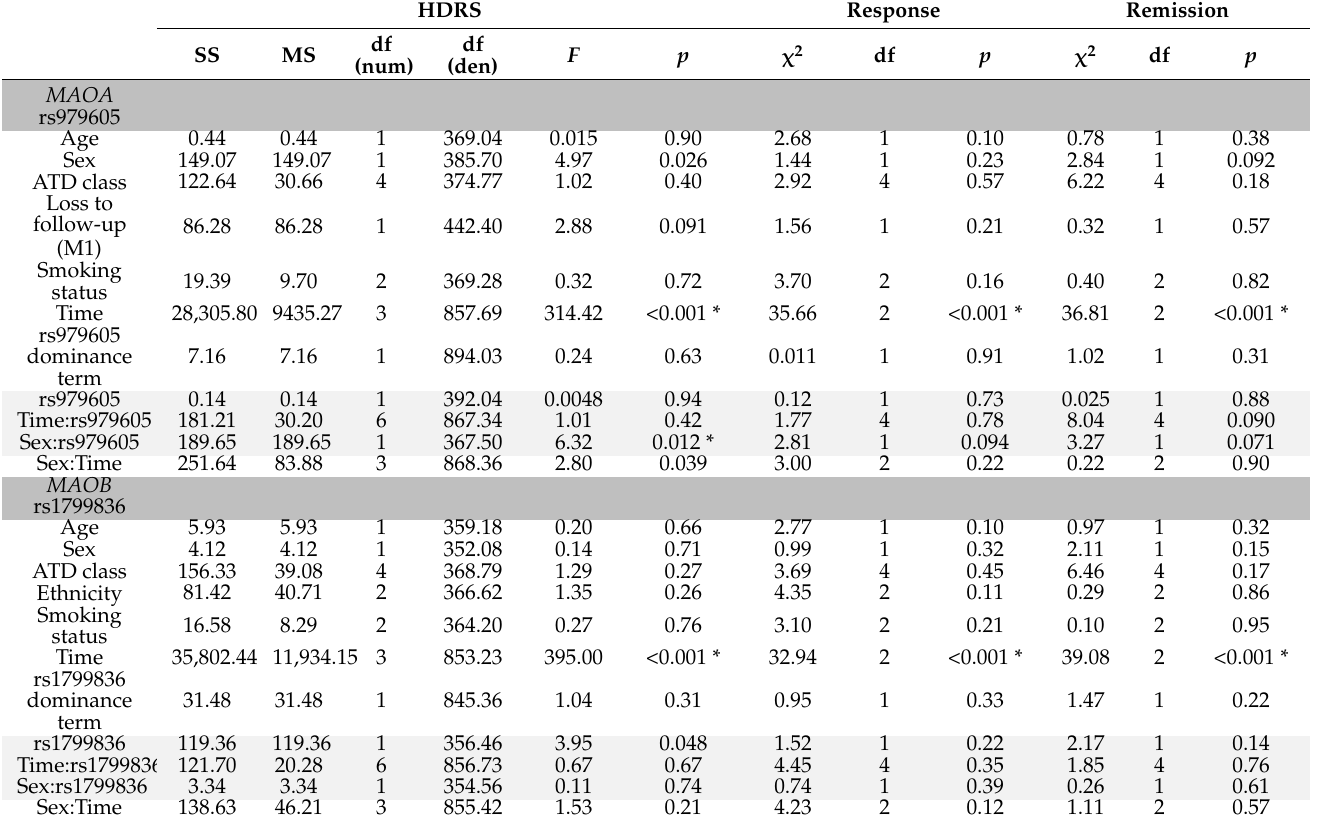
Table 5. Clinical associations with MAOA rs979605 and MAOB rs1799836 genotypes using the proposed full model for X-chromosomal